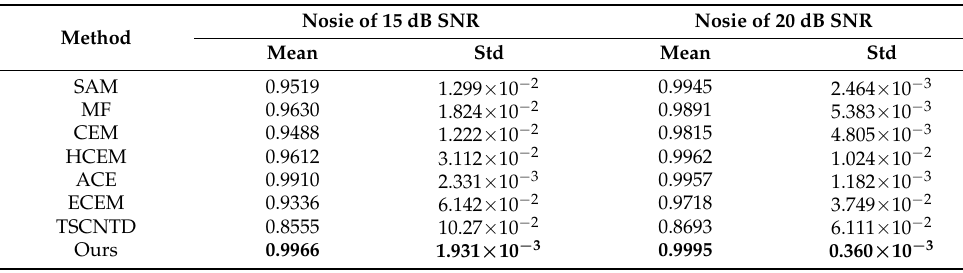
Table 4. AUC values of the different algorithms applied to the Synthetic data set under the interference of white noise with two SNR conditions. The best results are reported in bold.